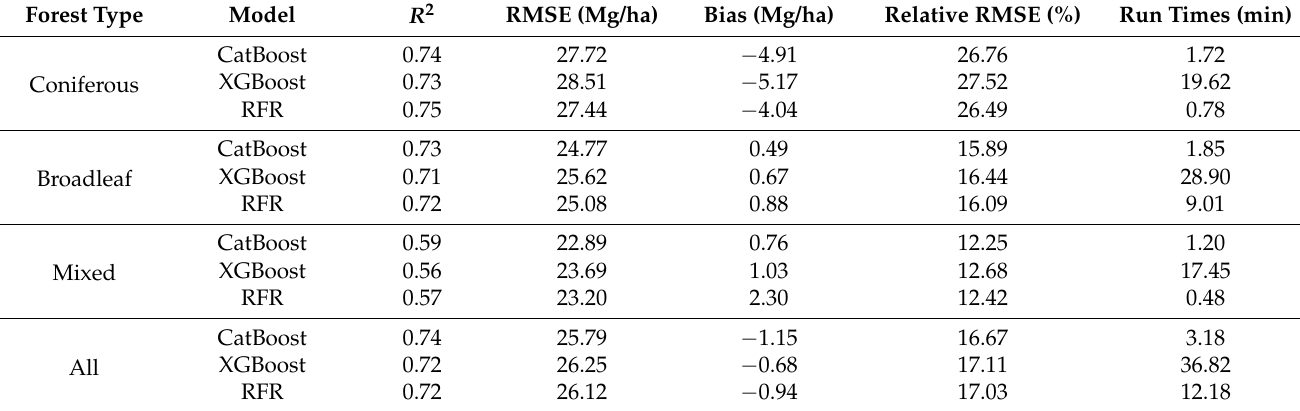
Table 7. AGB estimation accuracy assessment on validation dataset by combining VSURF with machine learning algorithms for different forest